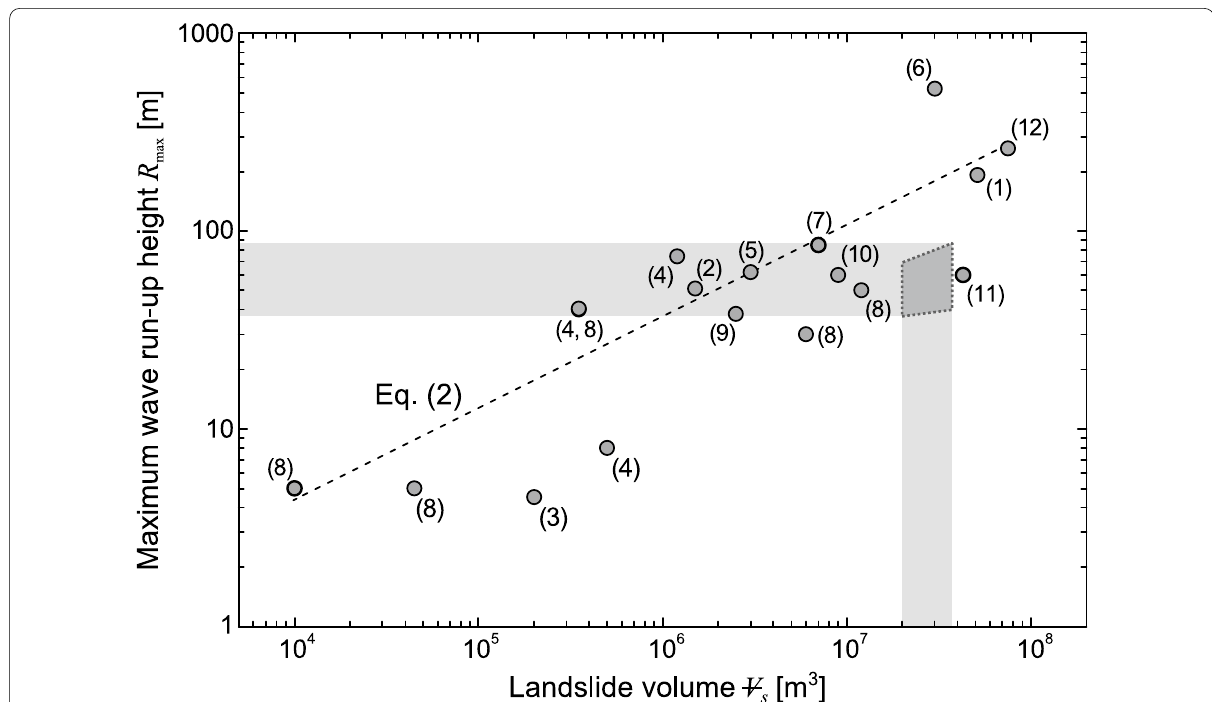
Fig. 9 Maximum run-up height R max versus landslide volume – V s . Data are composed of Lake Thun mass movement (grey: R max 10 6 … 35 10 6 m 3 ; dotted) and historical cases as compiled by Clark et al. (2015) and Leithold et al. (2019) including (1) Haeussler et al., (2018), × × (2) Evans (1989), (3) Hancox et al., (2003), (4) Hansen et al., (2016), (5) Jørstad (1968), (6) Miller (1960), (7) Naranjo et al., (2009), (8) Norwegian Water Resources and Energy Directorate (2016), (9) Roberts et al., (2013), (10) Watt et al., (2009), (11) Wiles and Calkin (1992), (12) Zaniboni and Tinti (2014) (adapted from Leithold et al.,